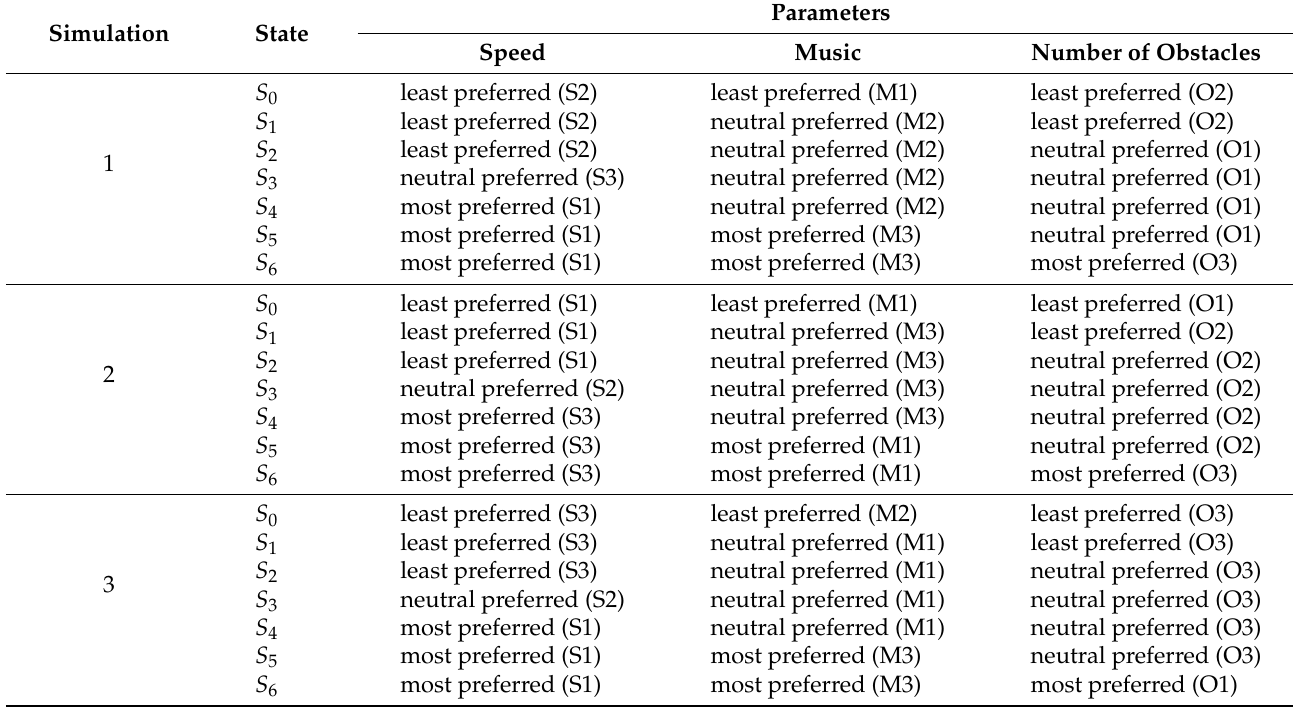
Table 4. Relationship of simulations with 3 different types of user